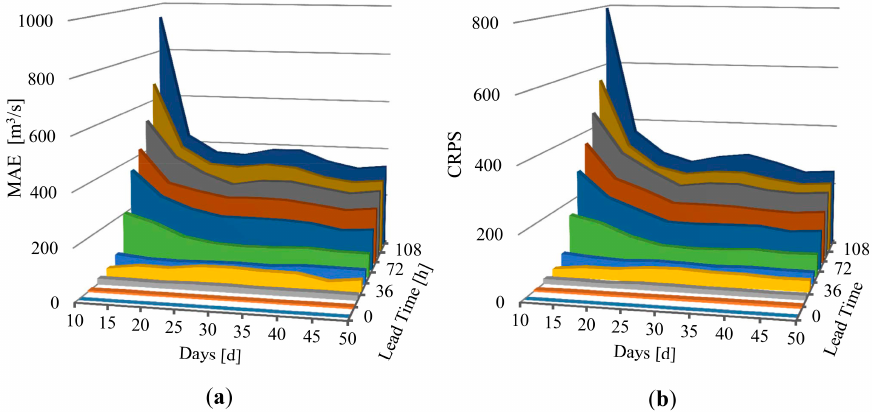
Figure 4. Comparison of training period lengths for lead times ranging from 6 to 120 h: ( a ) mean MAE over the verification period; ( b ) mean CRPS over the verification period.